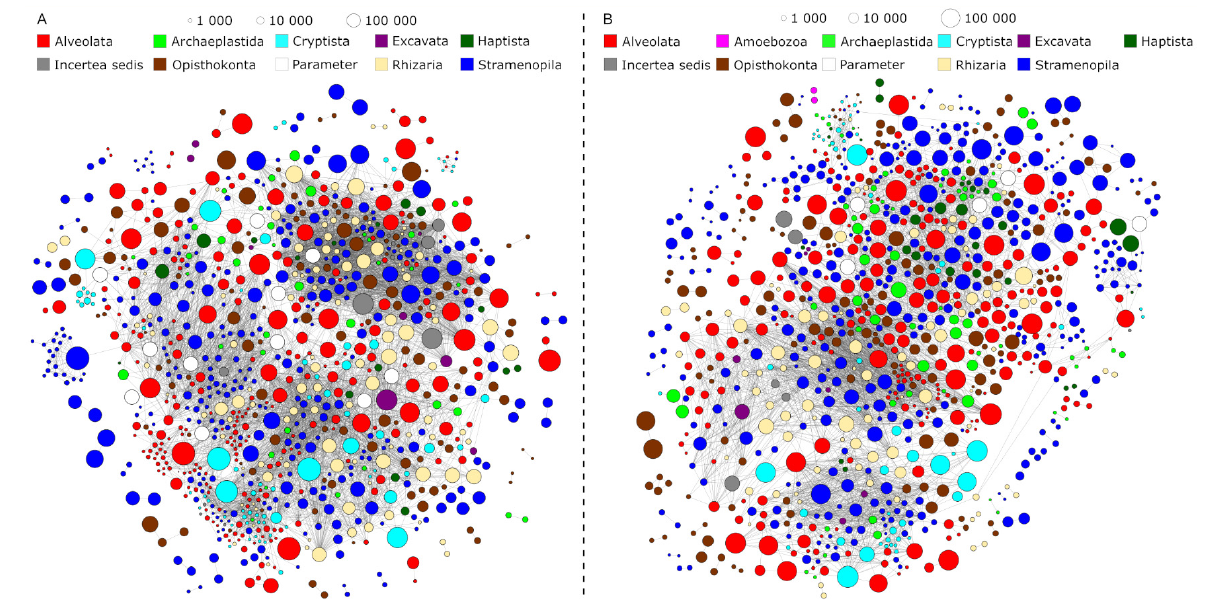
Figure 3. Seasonal protistan plankton co-occurrence networks. Panel ( A ) shows the cold season network, panel ( B ) the warm season network. Each node represents one network sequence cluster (NSC). Two nodes are connected by an edge if they were significantly co-occurring in the three-year time-series dataset of Lake Zurich. Node colors reflect the taxonomic assignment of NSCs on higher taxonomic levels. Node sizes reflect the read abundance of NSCs in the metabarcoding dataset.